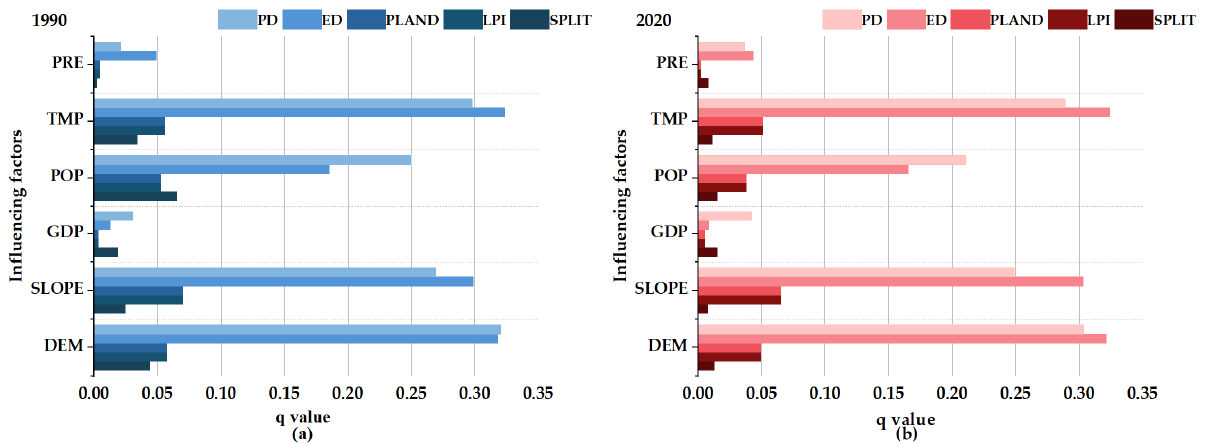
Figure 10. The force (q-value) among each influencing factor on each landscape pattern metric in ( a ) 1990 and ( b ) 2020.